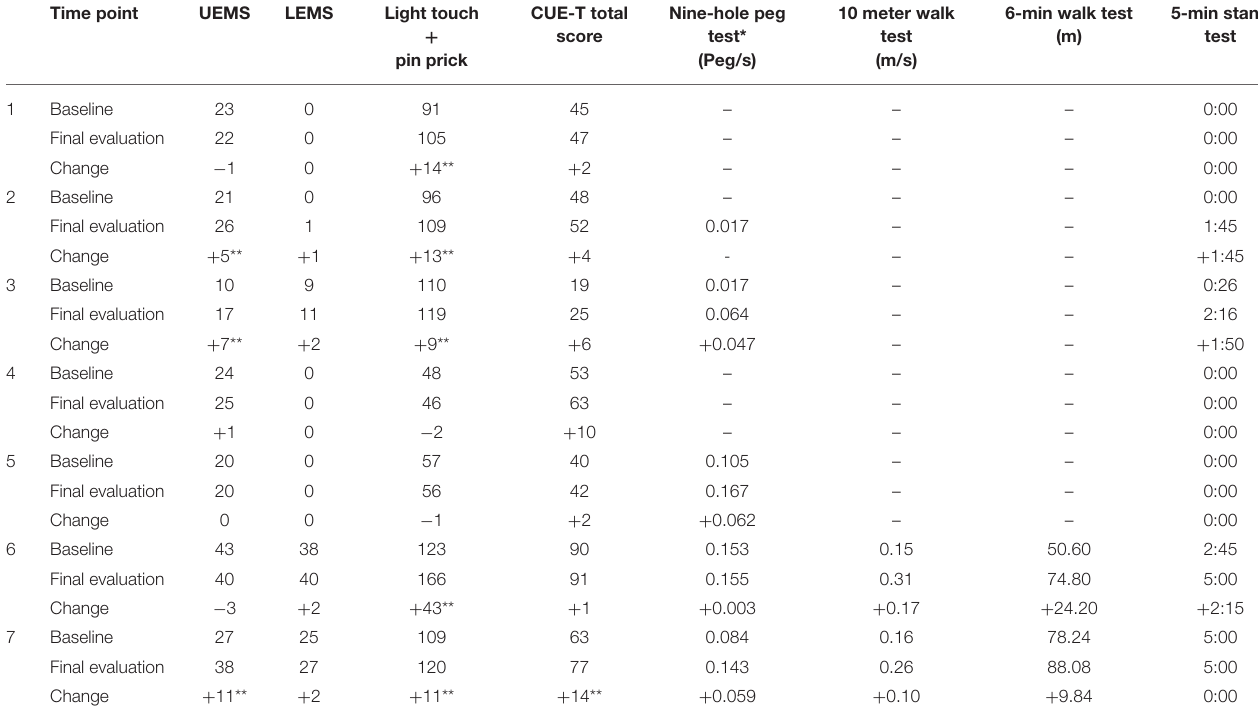
TABLE 2 | Baseline to post-TESS outcome change.